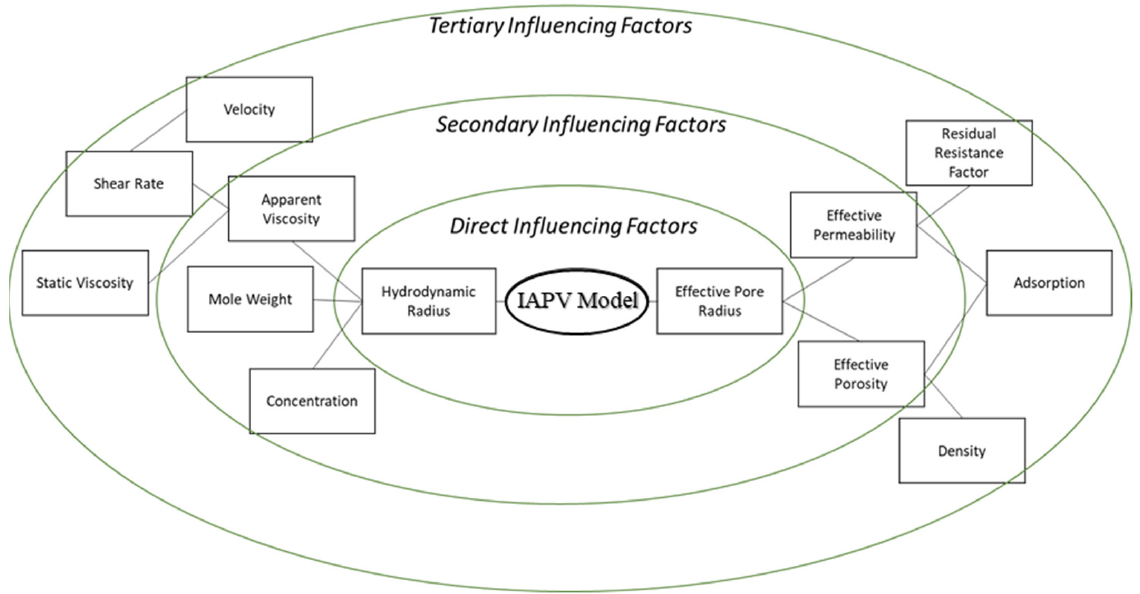
Figure 2. Illustration of factors that influence the gelant IAPV model.